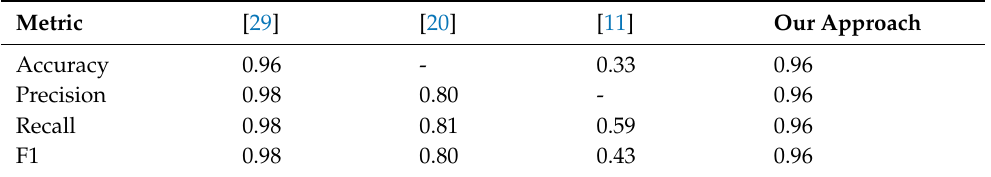
Table 5. Performance comparison for fake news detection.